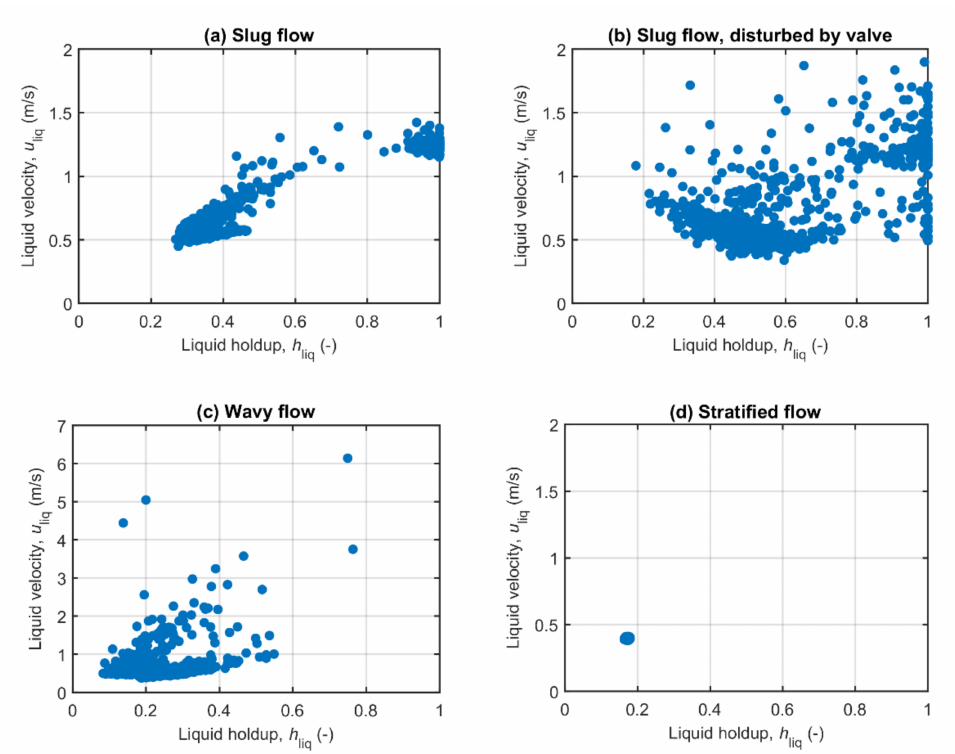
Figure 6. Measured liquid flow velocity as a function of measured liquid holdup for the same four flow experiments as for which the liquid distribution images were presented in Figure 5. These experiments correspond to: ( a ) Slug flow (Q gas = 11.5 m 3 /h and Q liq = 7.3 m 3 /h); ( b ) slug flow, disturbed by valve (Q gas = 10.4 m 3 /h and Q liq = 7.3 m 3 /h); ( c ) wavy flow (Q gas = 46.1 m 3 /h and Q liq = 2.6 m 3 /h); and ( d ) stratified flow (Q gas = 46.6 m 3 /h and Q liq = 1.1 m 3